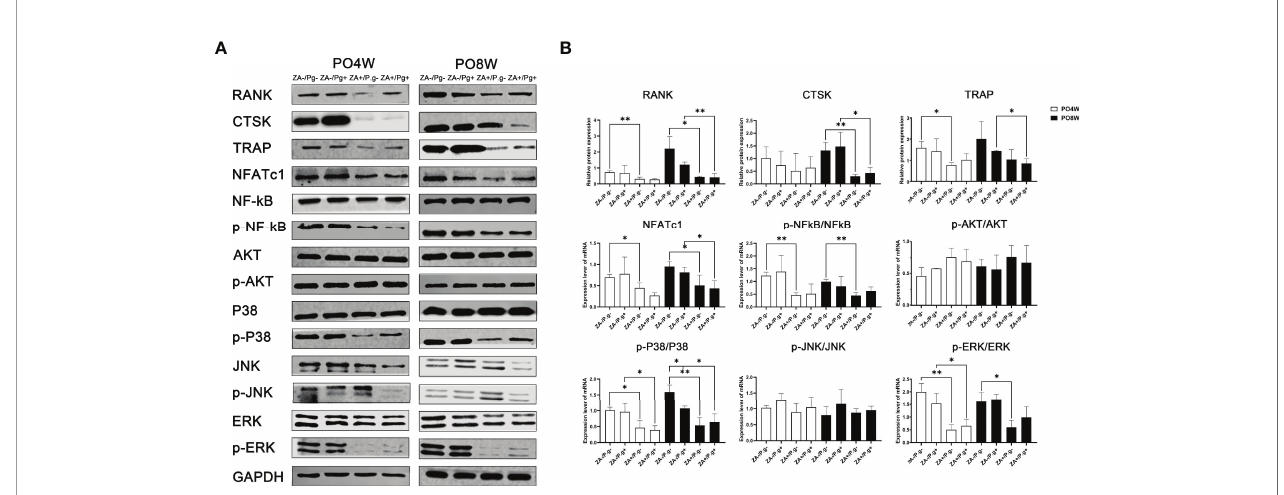
FIGURE 6 | ZA administration inhibited the expression level of osteoclastogenesis-related proteins through P38 MAPK, ERK MAPK and P65 NF- k B pathways. (A) Protein extracts were harvested from the cultured cells and subjected to Western blot analysis. (B) Quantitative analysis showed the expression levels of RANK, TRAP and NFATc1 were decreased in osteoclasts derived from the ZA-treated groups at 4 or 8 weeks postoperatively. The expression level of CTSK in the ZA- treated groups was signi fi cantly lower than that of the ZA-untreated groups; an effect seen only at 8 weeks postoperatively. The results showed ZA administration signi fi cantly decreased phosphorylation of p38 MAPK, ERK MAPK, and p65 NF-kB molecules but had no effect on JNK MAPK and AKT at 4 or 8 weeks postoperatively. There was no statistical difference in the expression level of osteoclastogenesis- and pathways- related proteins between P. gingivalis -treated and P. gingivalis -untreated groups except for the p38 pathway at 8 weeks postoperatively. PO4W, postoperative 4 weeks; PO8W, postoperative 8 weeks. *p <0.05, **p